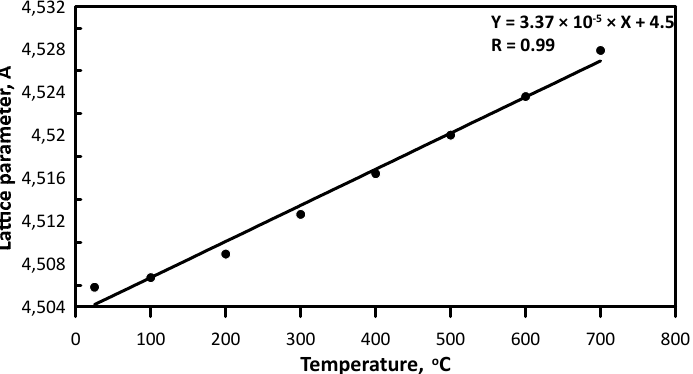
Figure 4. La tt ice parameter of the sintered (Hf,Zr,Ti,Nb,Mo)C ceramic at versus temperature. The reflexes of (Hf,Zr,Ti,Nb,Mo)C solid solution were not observed at temperatures higher than 745 ◦ C. In the temperature range from 25 to 600 ◦ C, the size of (Hf,Zr,Ti,Nb,Mo)C solid solution coherent diffracting domain was around 63 nm, while at 700 and 725 ◦ C–50 and 30 nm, respectively.